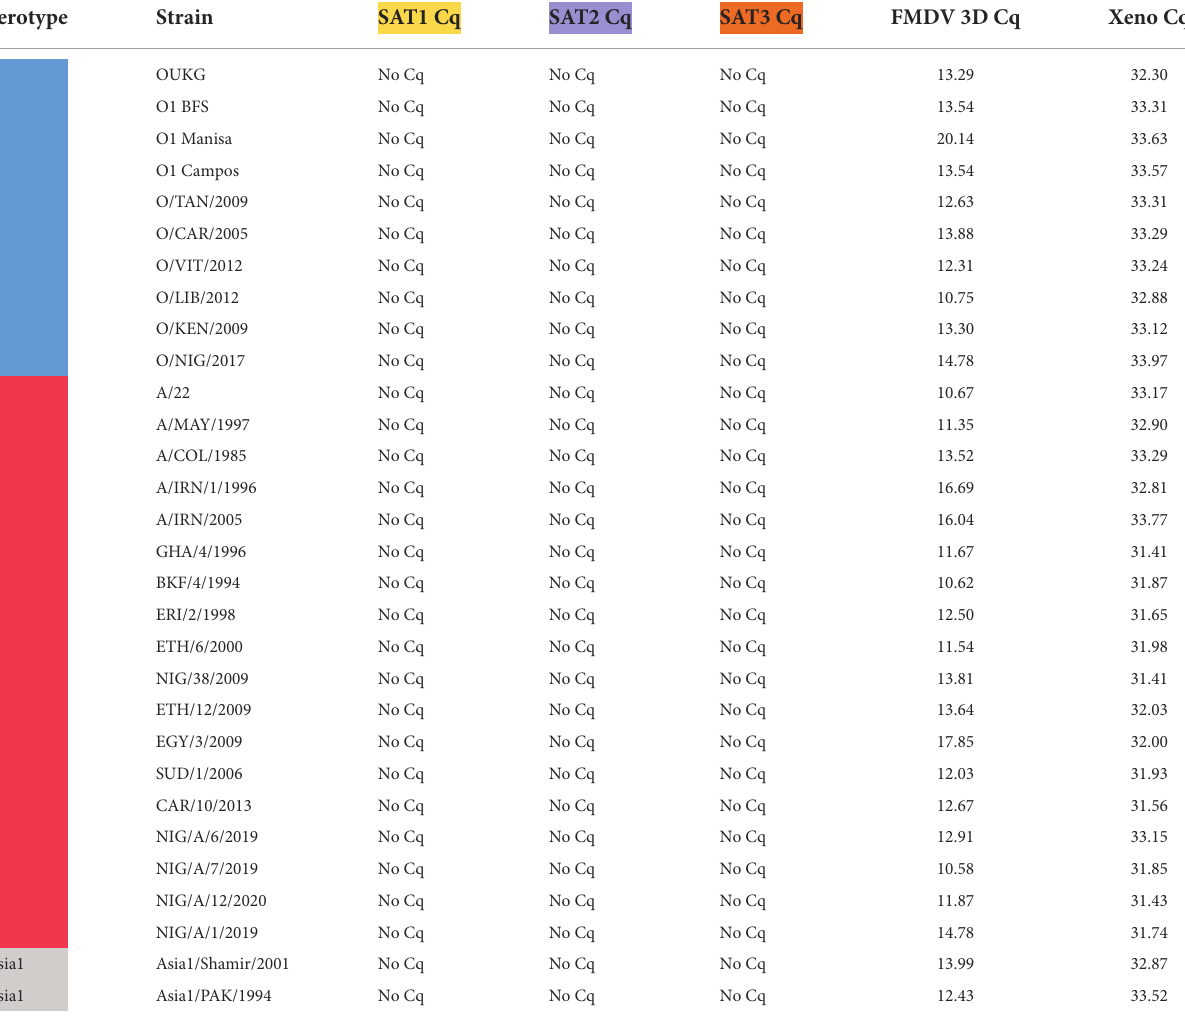
TABLE 3 Detection of FMDV A, O and Asia1 cell culture isolates with the serotype-specific SAT1, SAT3 and SAT2 topotype VII rRT-PCR assays.